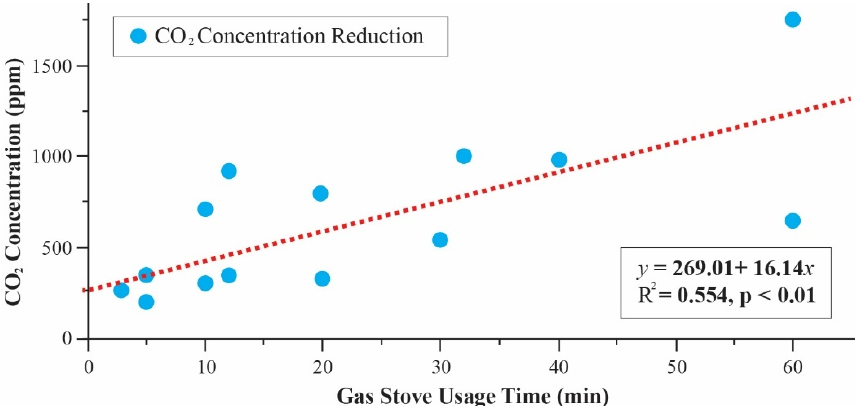
Figure 12. CO 2 concentration by gas stove usage time.